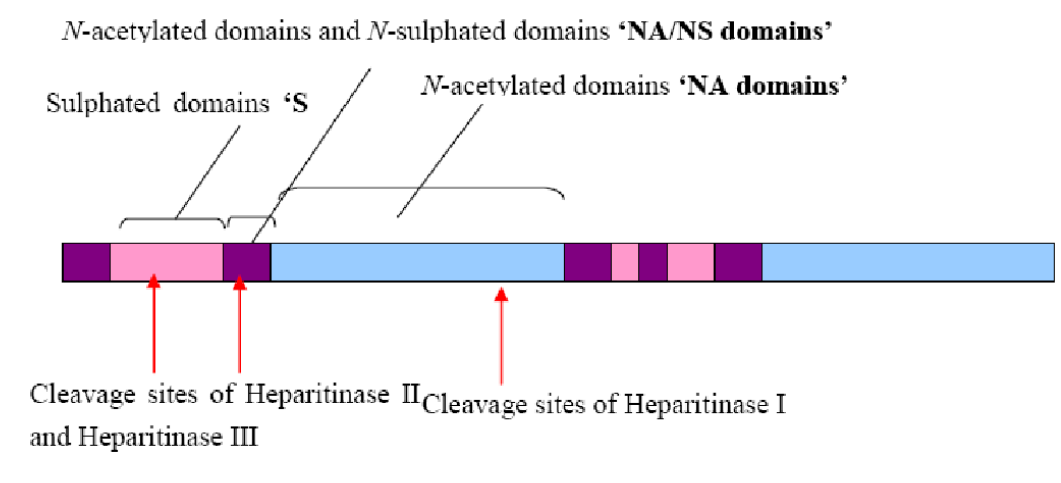
Figure 3. Diagram representing different domains present in HS chains. Sulphated domains ( S -domains) contain N -sulphated disaccharides with IdoA-2- O - sulphate as a major uronate component. N -acetylated (NA) domains are non-sulphated and have acetylated regions. In contrast, N -acetylated and N -sulphated (NA/NS) domains contain alternating N -acetylated and N- sulphated units. The cleavage sites for commonly used heparitinase digestion enzymes are shown [11]